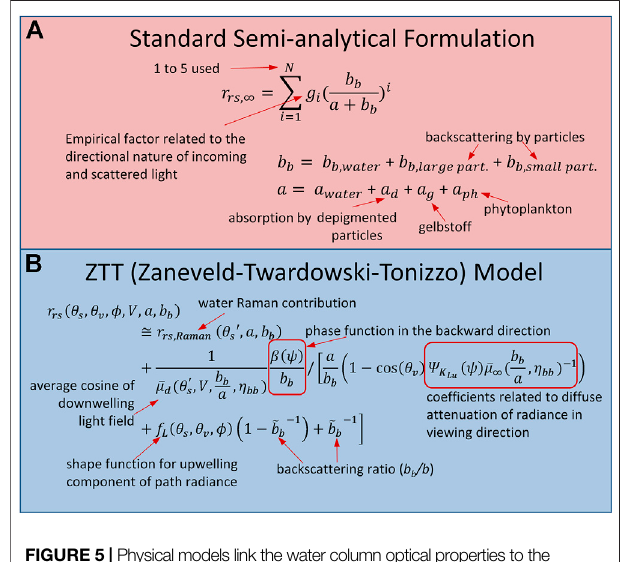
FIGURE 5 | Physical models link the water column optical properties to the light fi eld measured by a satellite. (A) Most semi-analytical algorithms use a simpli fi cation where the directional nature of light is approximated with empirical constants(Werdelletal.,2018). (B) AnewlyposedZTTmodelparameterizes the shape of light in the backward direction (phase function), the shape of the upwellingcomponentofpathradianceandtheaveragecosineofdownwellinglight Twardowski and Tonizzo